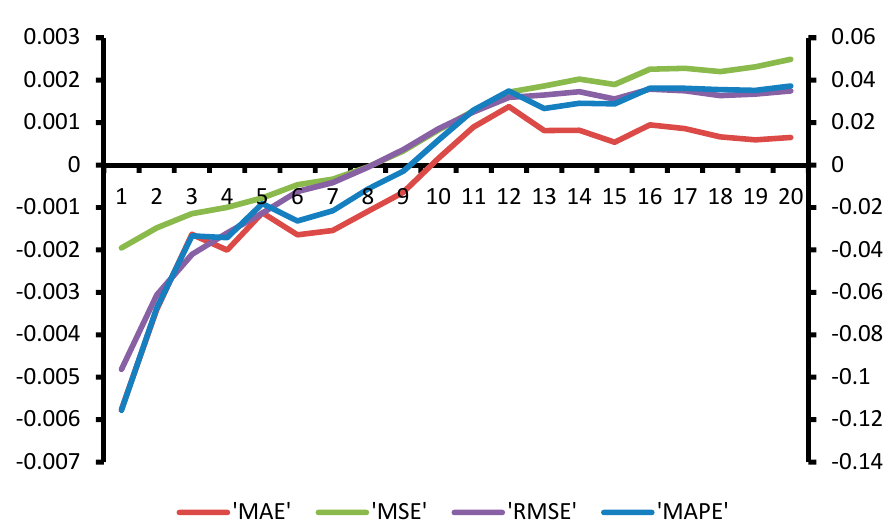
Figure 3. Differential errors between predictions when using only prices of CO 2 emission allowances and when electricity prices are added.